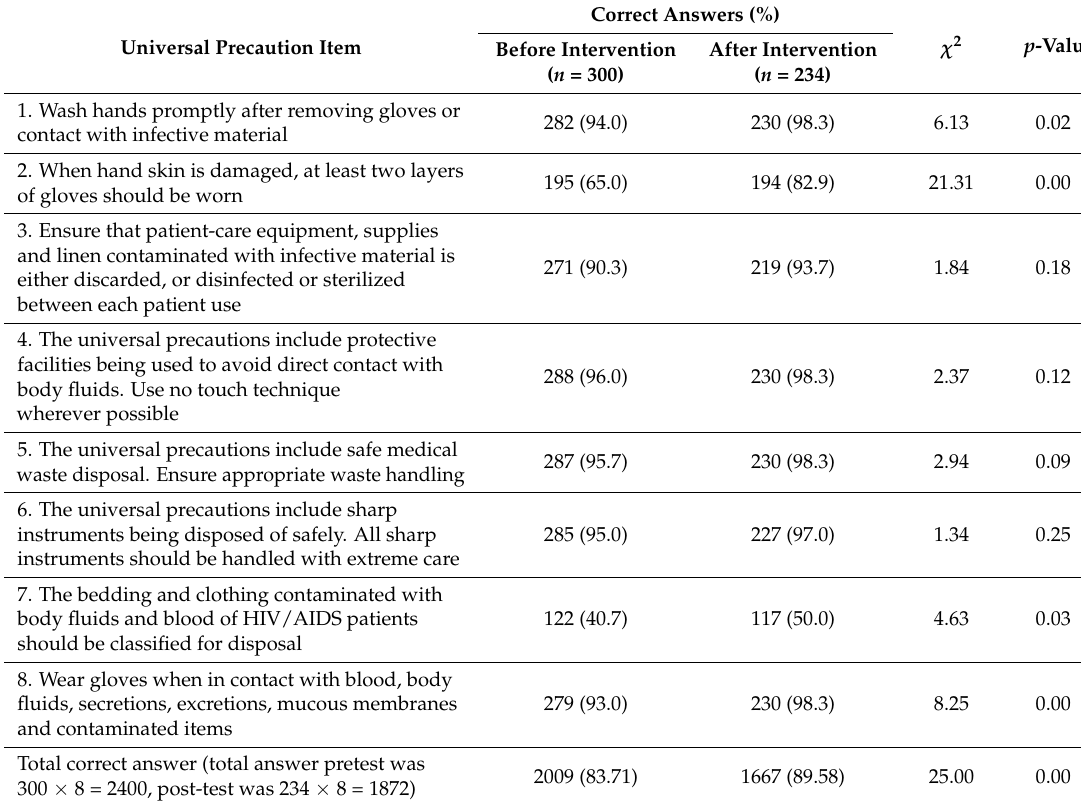
Table 6. Intervention effect on universal precaution